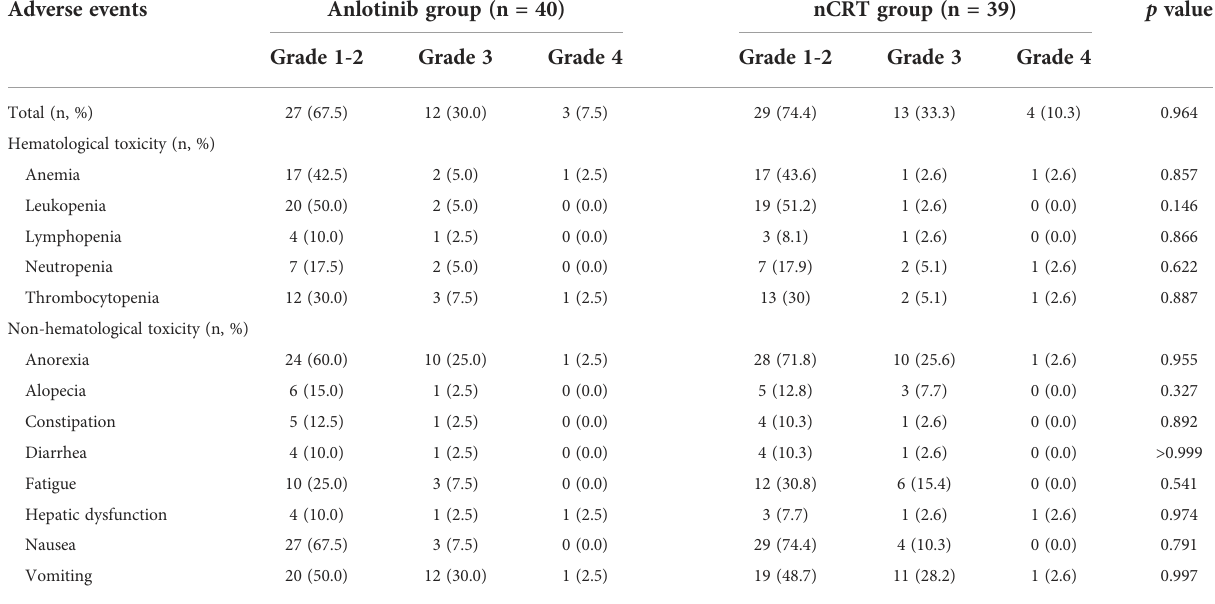
TABLE 5 Treatment-related adverse